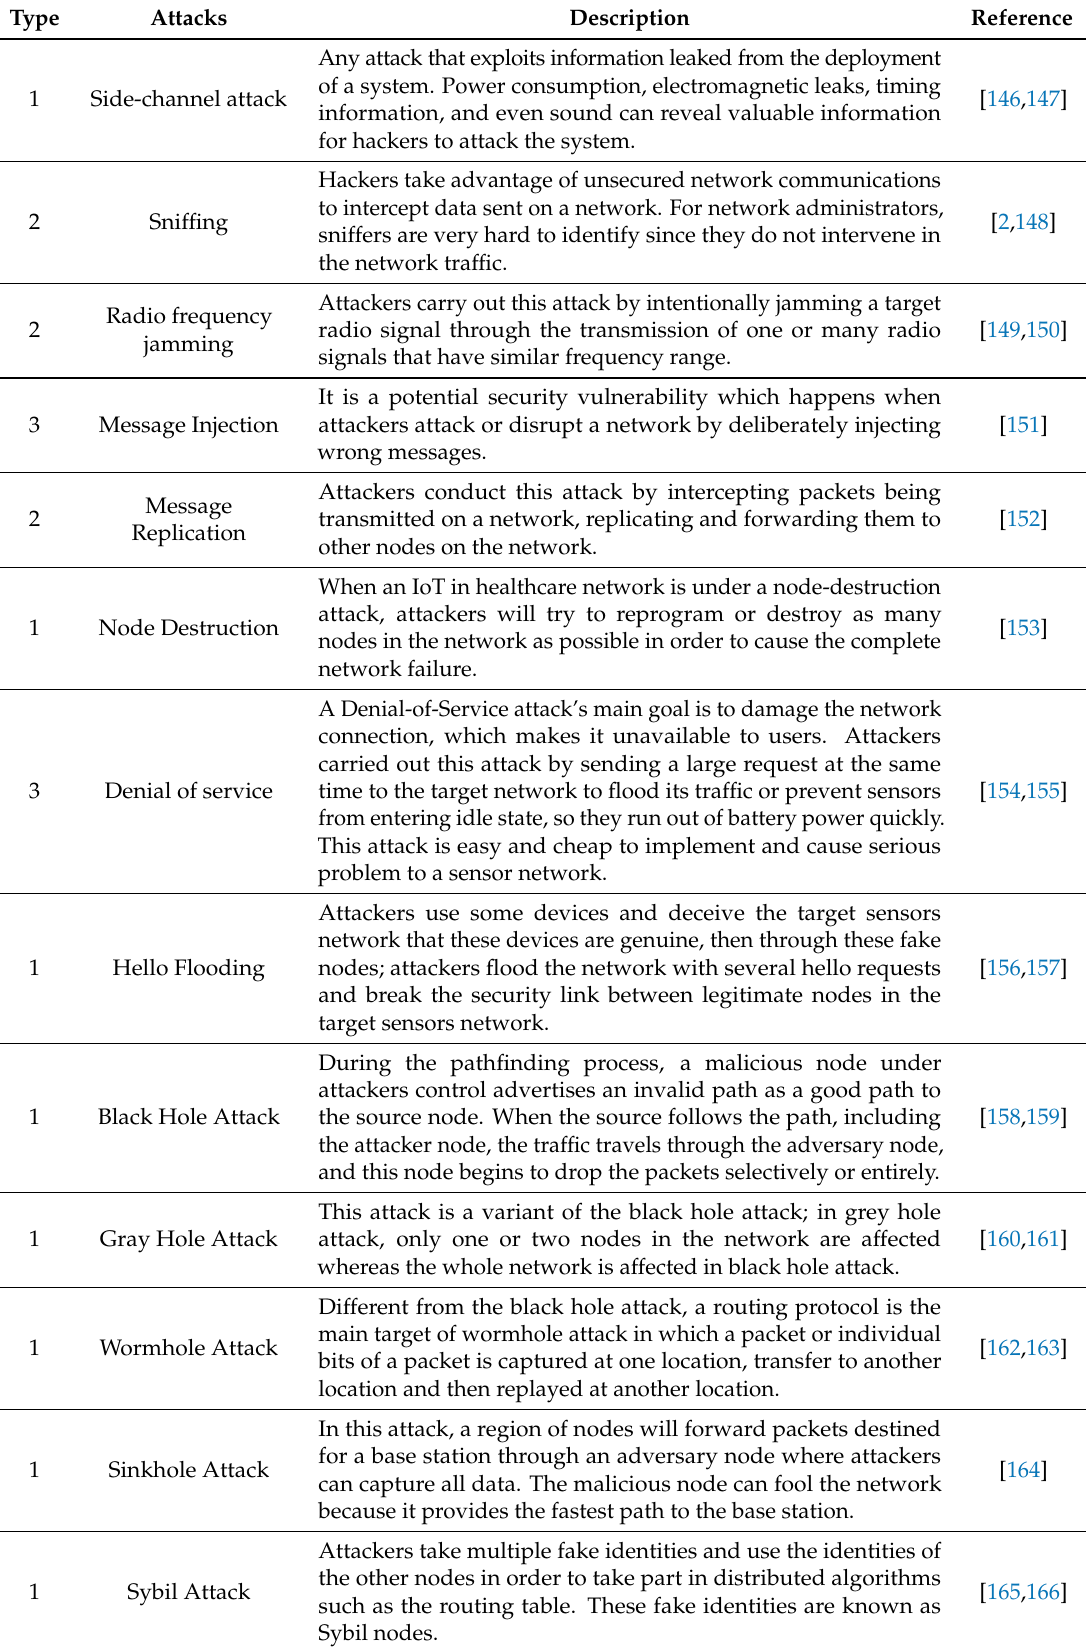
Table 10. Different types of attacks on an IoT for healthcare